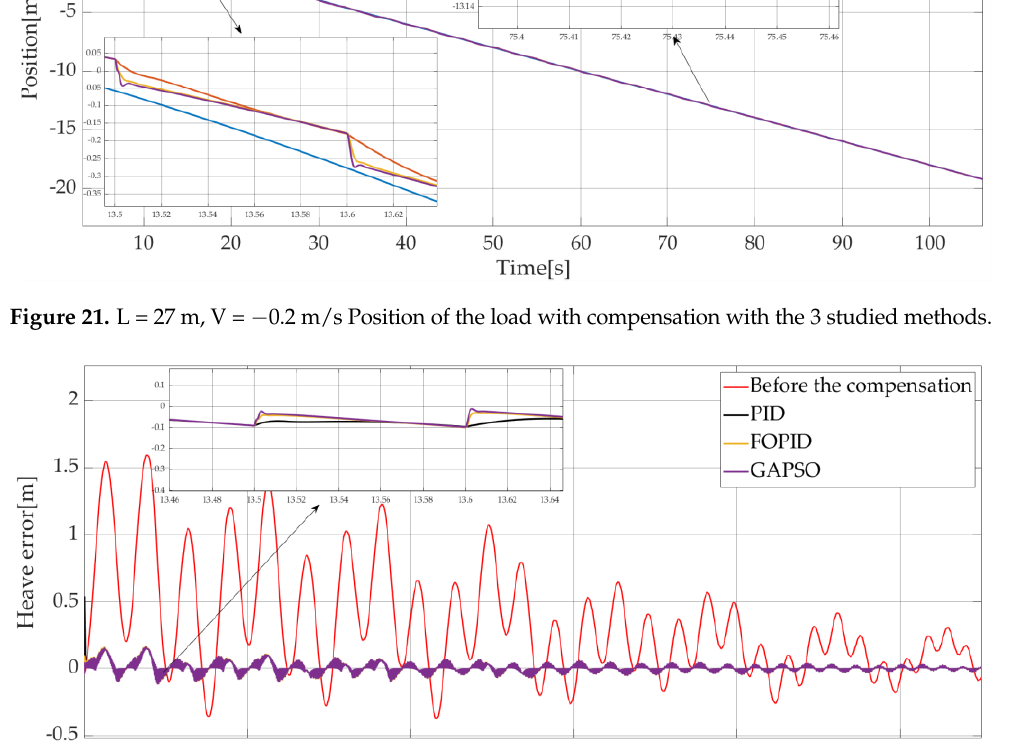
Figure 22. L = 27 m, V = − 0.2 m/s, Heave errors with and without compensation. Table 7. Compensation efficiency for different algorithms and the results of Figure 22.